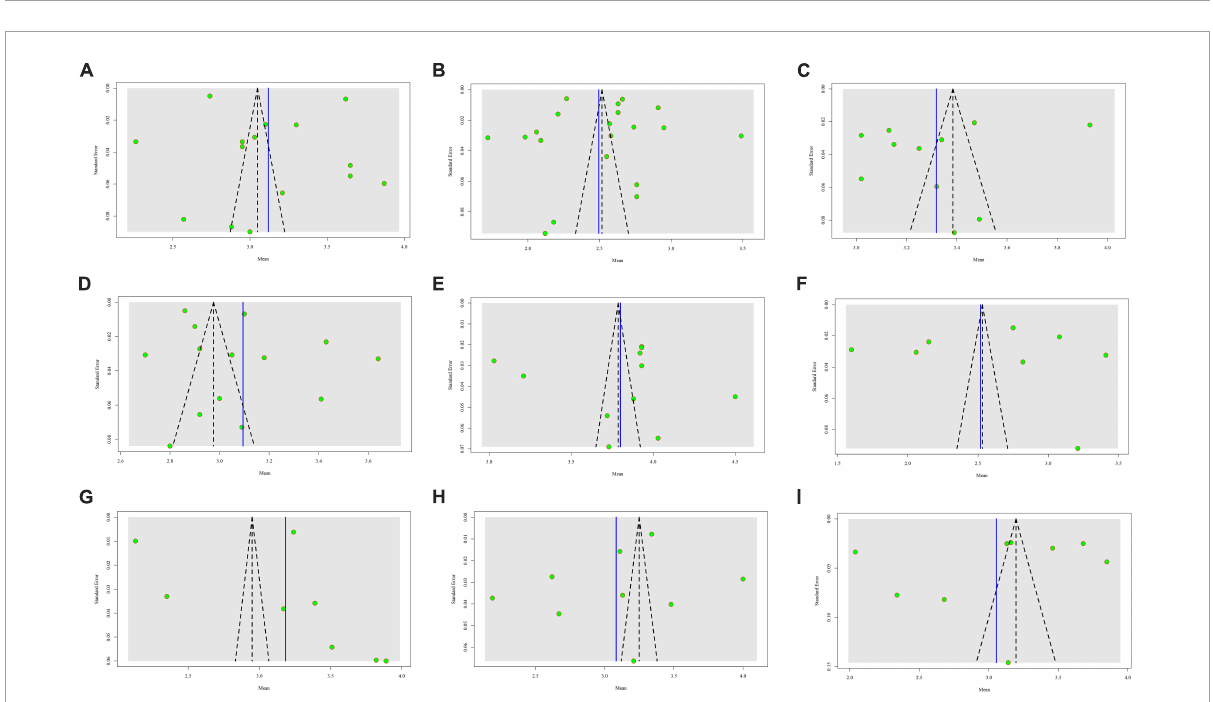
FIGURE5 Funnel plot of each theme. (A) Career development; (B) financial rewards; (C) governance; (D) infrastructure; (E) interpersonal relationship; (F) job security; (G) respect; (H) work value; and (I) work stress.